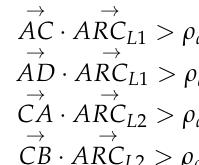
Figure 4. The area range of a pair of arc-support line segments.